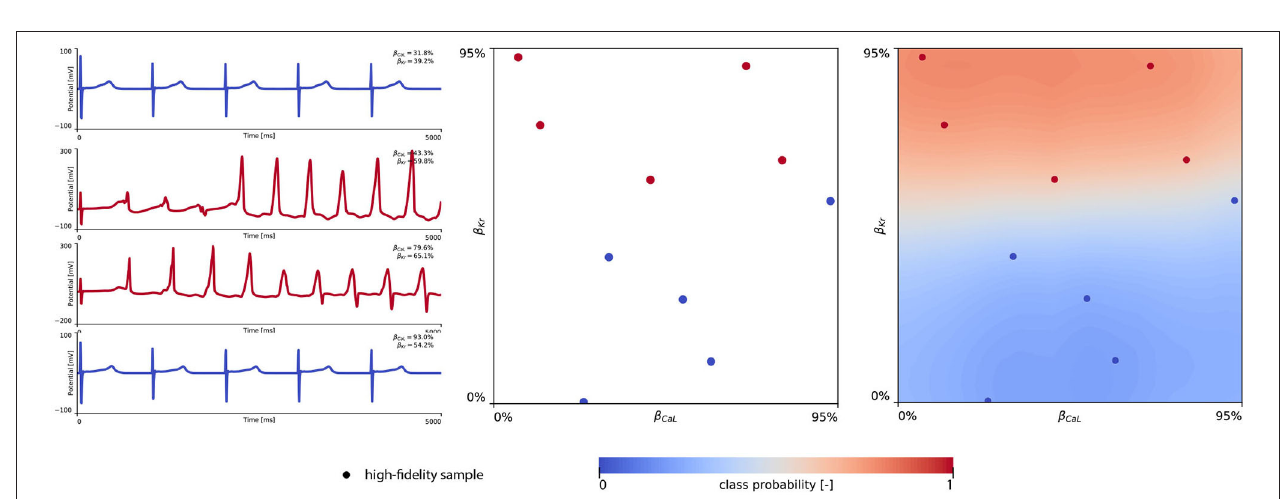
FIGURE A4 | Female single-fidelity multiscale arrhythmogenic risk classifier. Initial single high-fidelity exploration of the female drug-induced arhhythmogenic risk parameter space. The middle plot showcases 10 internal latin hypercube { β Kr , β CaL } sample evaluations of arrhythmogenesis in the female heart. The virtual electrocardiograms for two arrhythmogenic and 2 non-arrhythmic sample evaluations are shown in the left plots. The resulting exploratory female single high-fidelity drug-induced arrhythmogenic risk classifier is shown in the right